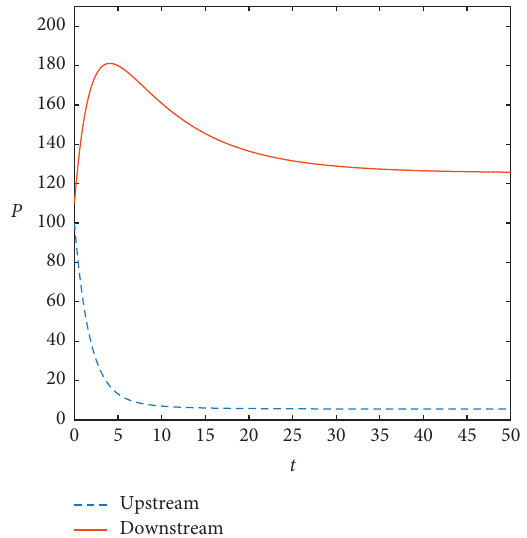
Figure 16: Optimal trajectory of pollution stock under non-co- operation when the planning period T ⟶ ∞ .